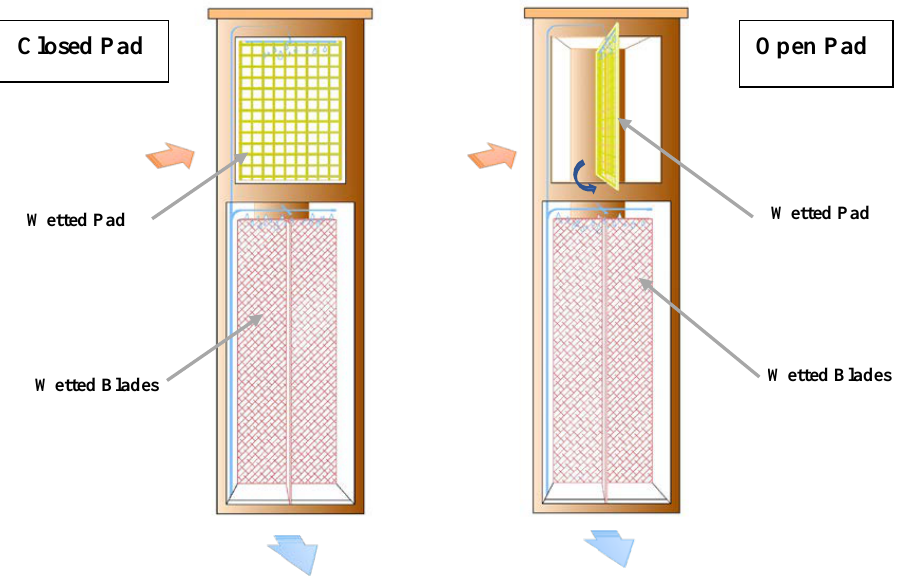
Figure 1. The schematic view of the designed wind catcher with open and closed pad.